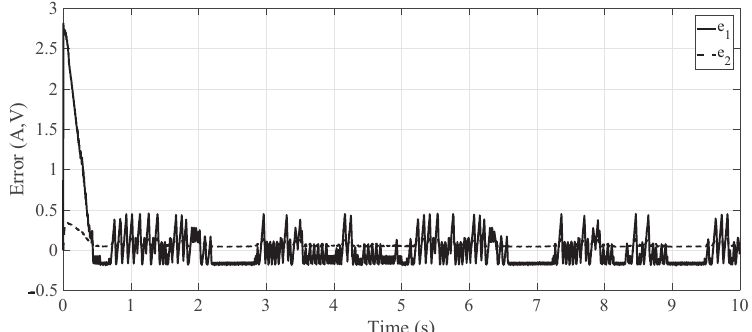
Figure 13. Error signals for MPPT test.